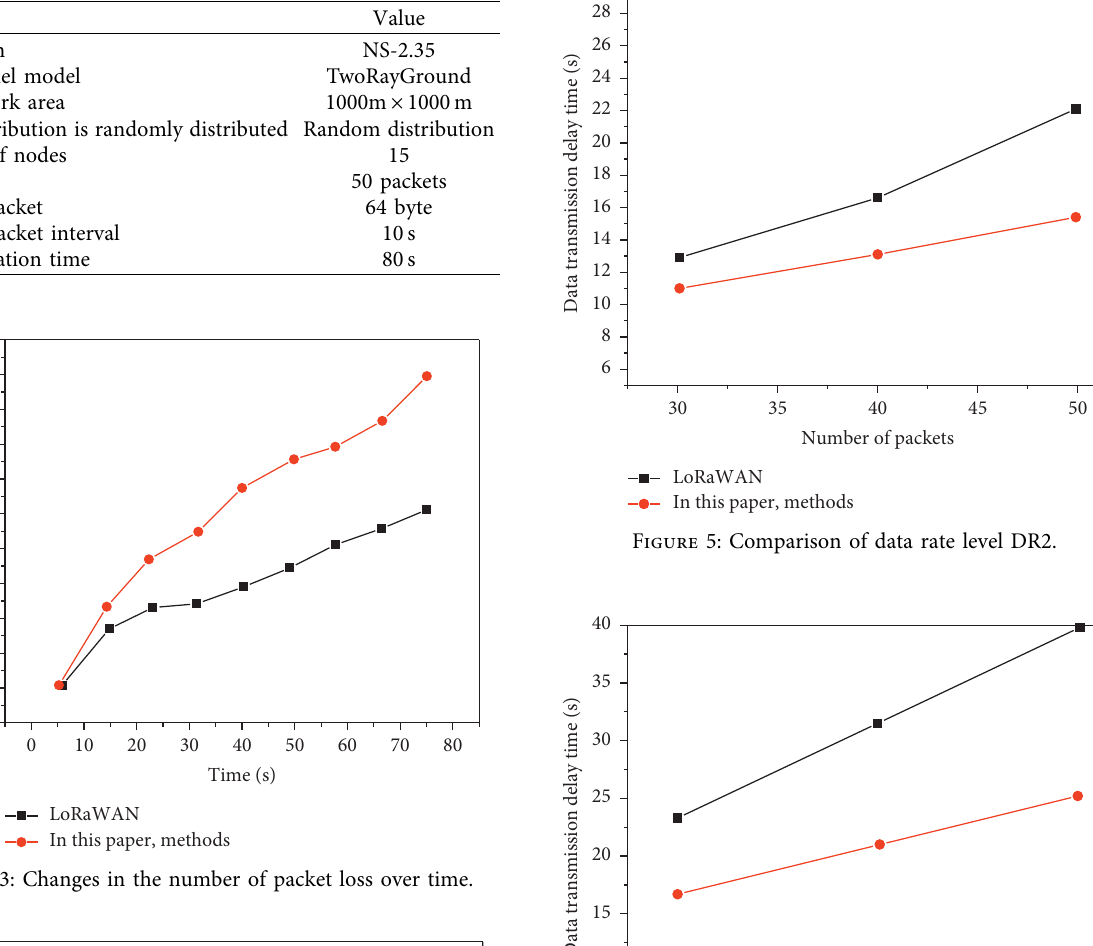
Table 1: Main simulation parameters.